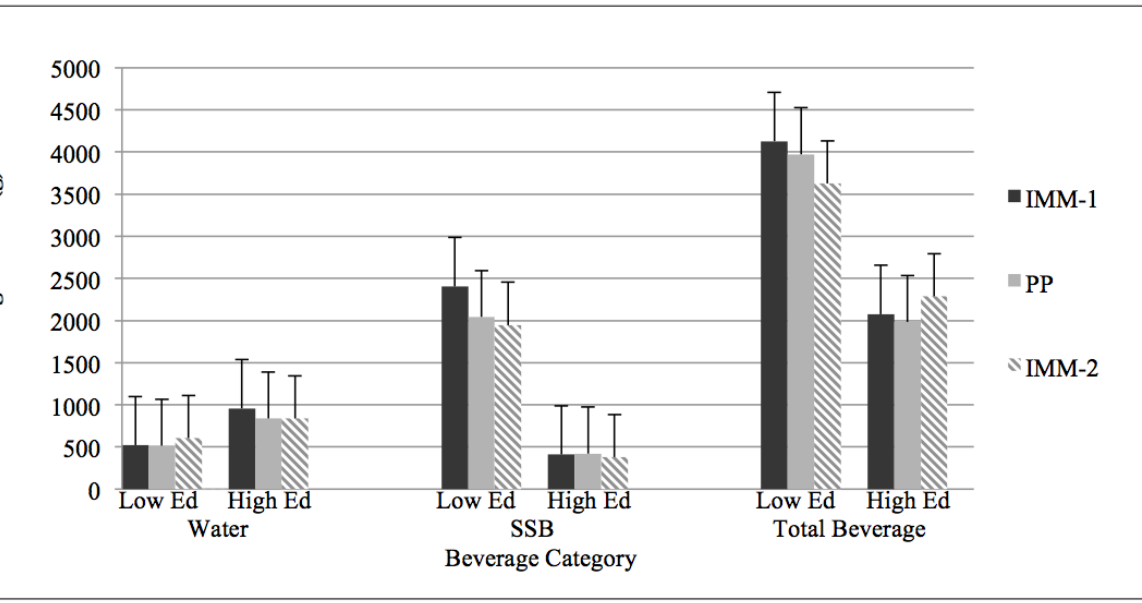
Figure 2. Beverage intake in grams for education categories. The following abbreviations mean: Low Ed=Less than high school/high school; High Ed=Some college/college degree; SSB=Sugar-sweetened beverages; IMM=Interactive Multi-media, 2 separate administrations; and PP=Paper and Pencil version. The "Water" "Low Ed" solid black and solid grey bars and the "Total Beverage" "Low Ed" grey-striped bar show a significant difference from "High Ed" group ( P =.02). The "SSB" "Low Ed" solid black, solid grey, and grey-striped bars and "Total Beverage" "Low Ed" solid black and solid grey bars show a significant difference from "High Ed" group ( P <.001).